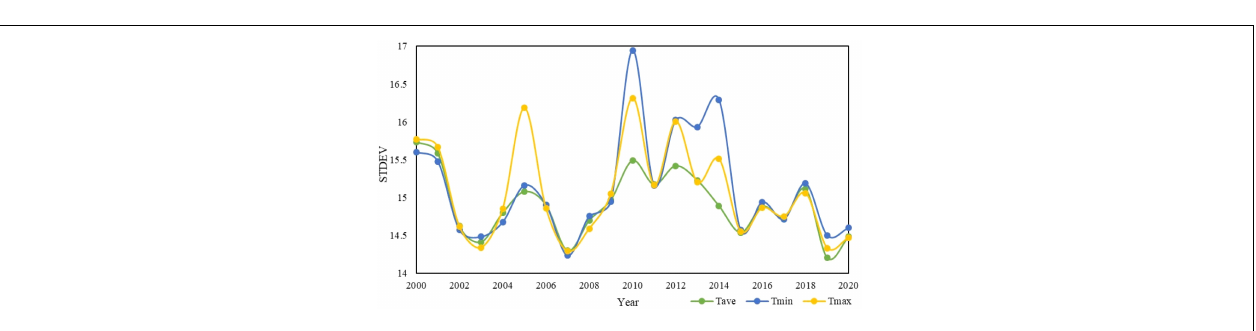
FIGURE A3 | Standard deviation of annual average temperature in Songnen Plain from 2000 to 2020.